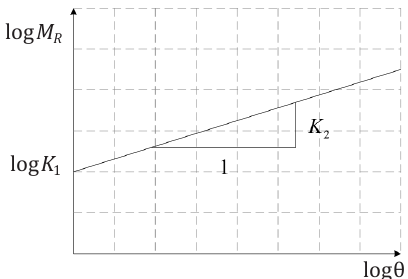
Figure 1. Log plot of Eq.